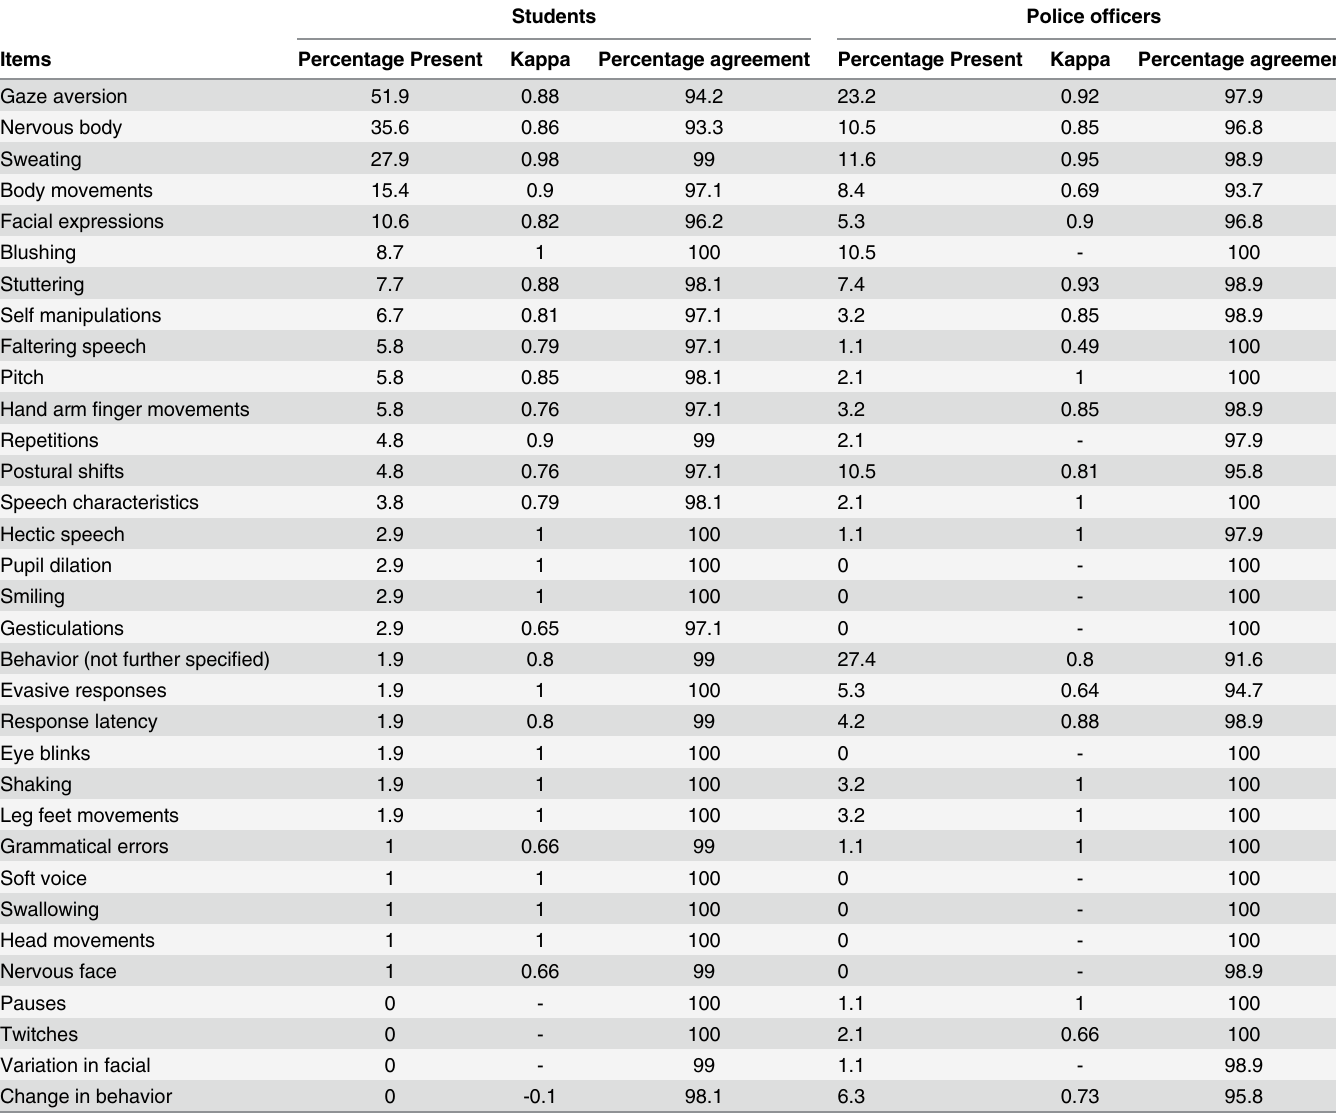
Table 1. Percentage of students (n = 104) and police officers (n = 95) mentioning nonverbal